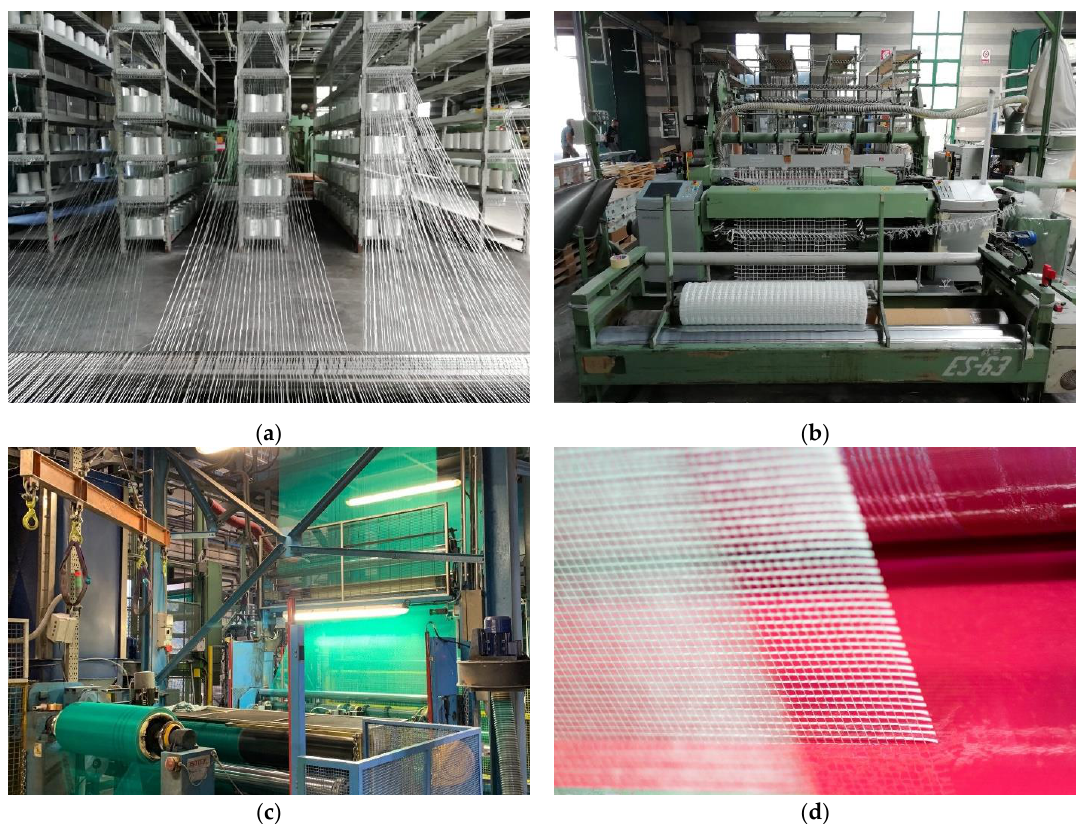
Figure 1. Textile manufacturing phases: AR-glass spools on the creel ( a ), weaving loom machine ( b ), impregnation machine ( c ), and detail of the dip-coating process within the impregnation tank ( d ).